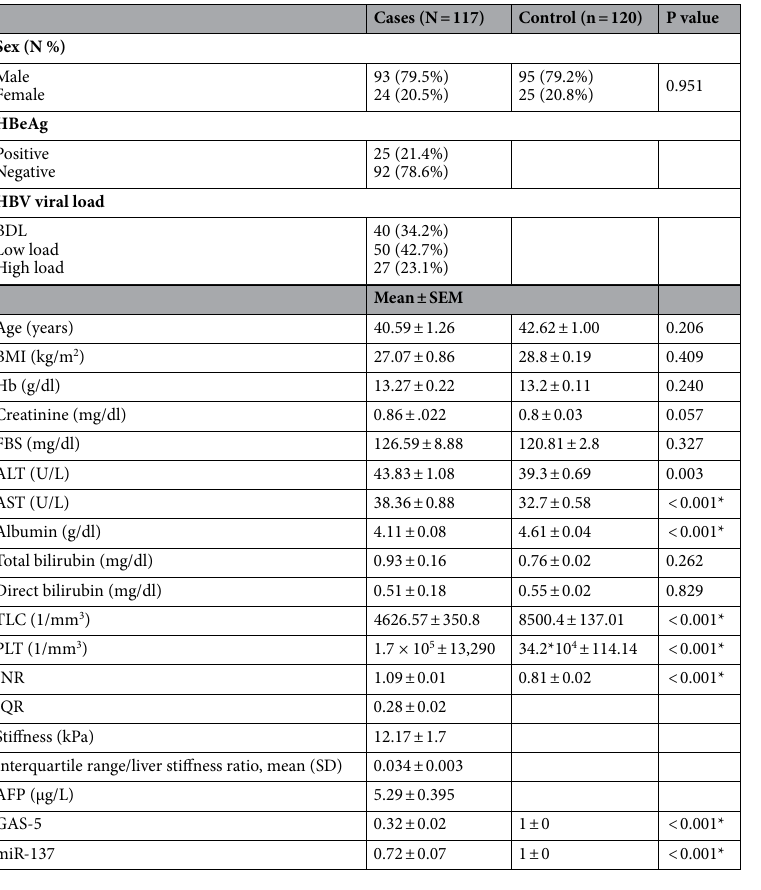
Table 1. Demographic, clinical and laboratory of study subjects. Data are expressed as mean ± SEM (standard error of mean); expression values of GAS5 and miR-137 in control group were set as 1. BMI body mass index, GAS-5 lncRNA growth arrest-specific 5, miR-137 microRNA 137, AFP alpha fetoprotein, FBS fasting blood sugar, IQR interquartile range, Hb hemoglobin, TLC total leucocytic count, PLT platelet count, INR the international normalized ratio, kPa kilopascals, ALT alanine aminotransferase, AST aspartate aminotransferase, BDL below detection level (below 20 copies/ml), low load viral load 20–10 4 copies/ml, high load viral load > 10 4 copies/ml.